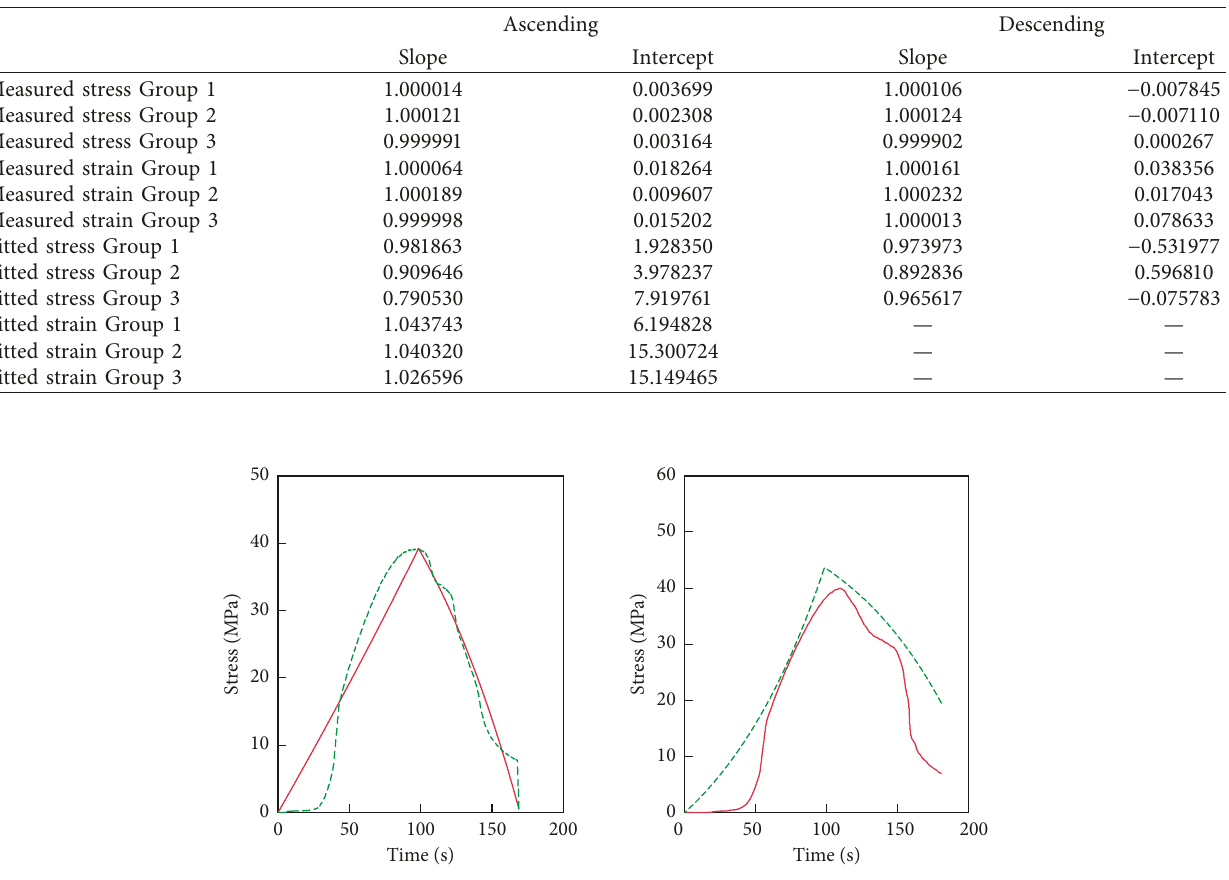
Table 2: Coefficients of linear evolution